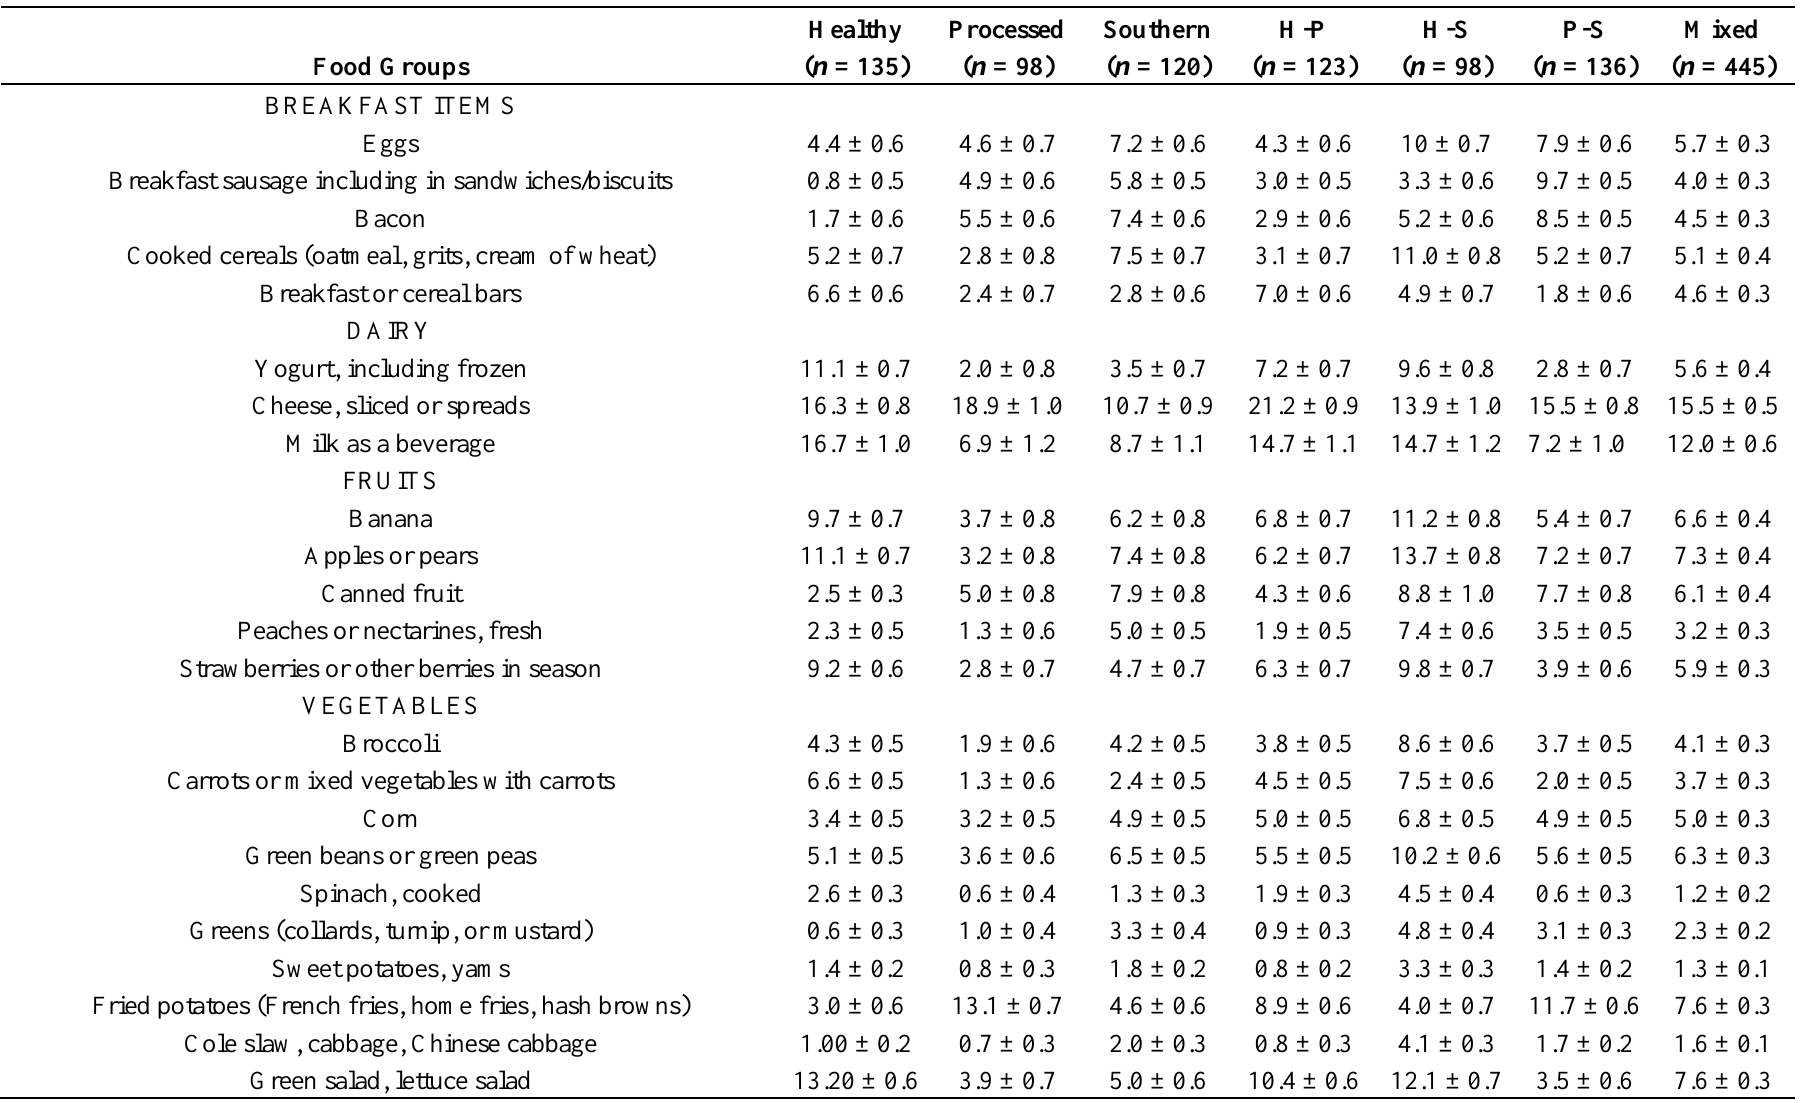
Table 2. Average monthly frequency of intake of food groups in the seven dietary patterns 1 . Healthy Processed Southern H-P H-S P-S Mixed Food